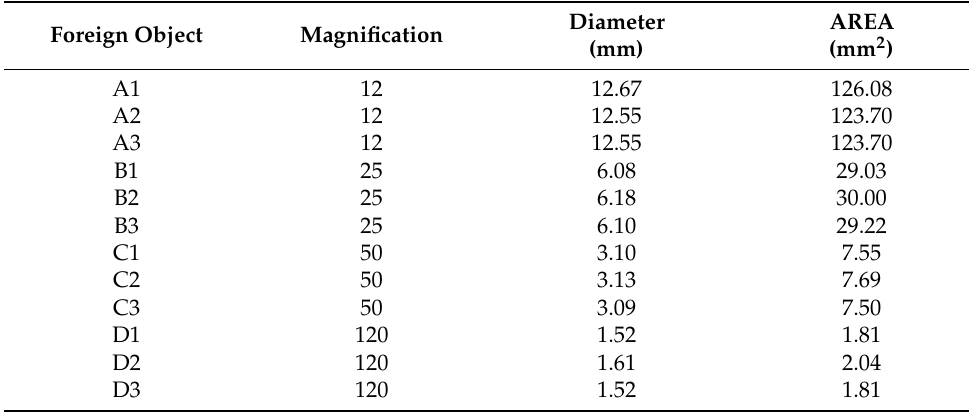
Figure 1. Measurement of the diameter of B2 imaged by the Keyence VR 3000. Table 1. Summary of Imaging Results of PTFE Inclusion Using 3D Microscopy.